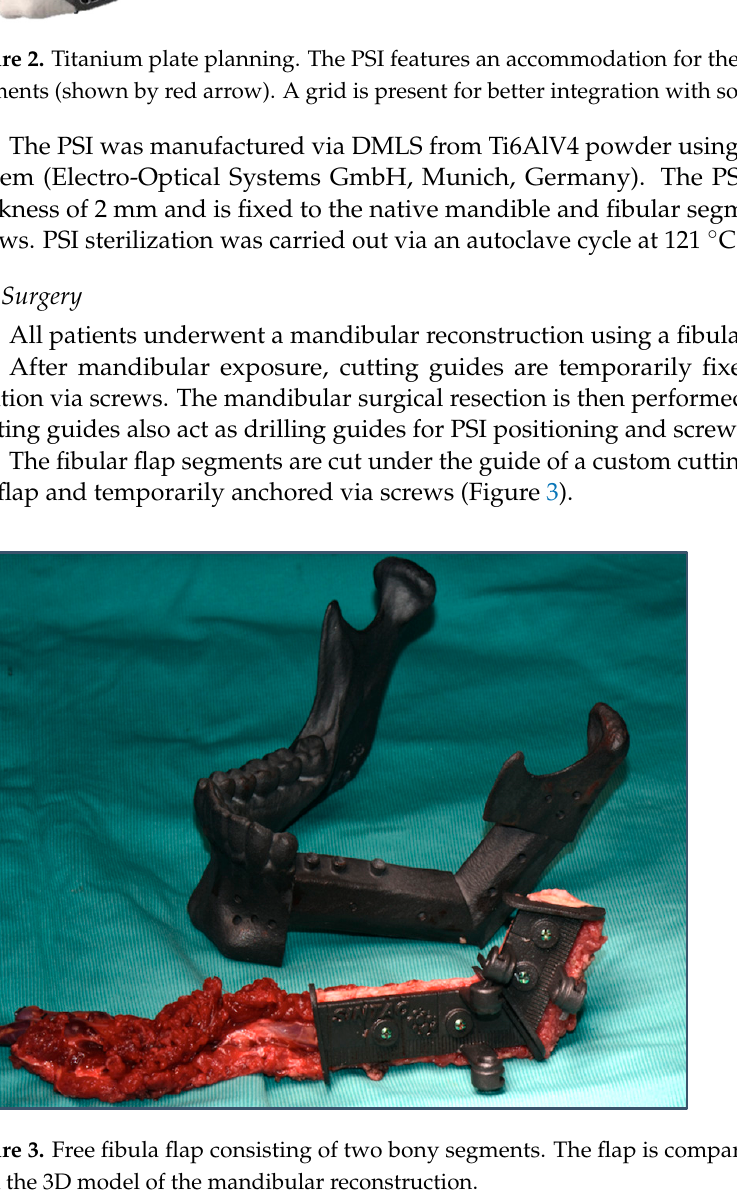
Figure 3. Free fibula flap consisting of two bony segments. The flap is compared morphologically with the 3D model of the mandibular reconstruction.